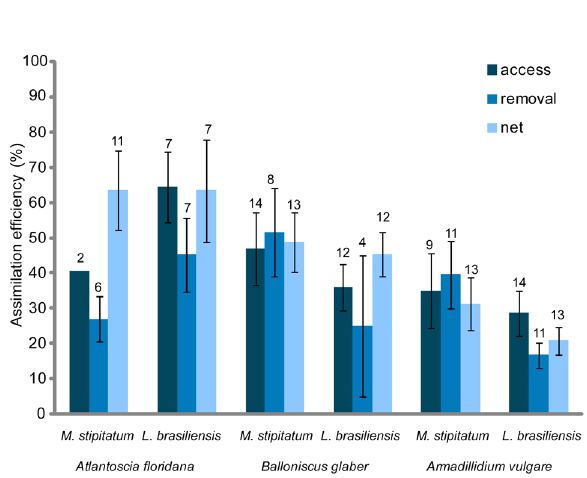
Figure 2. Consumption rates of three different isopod species with two different food sources in three different treatments (access, removal and net). The values are mean ± SE and the numbers on top indicate the sample for each index